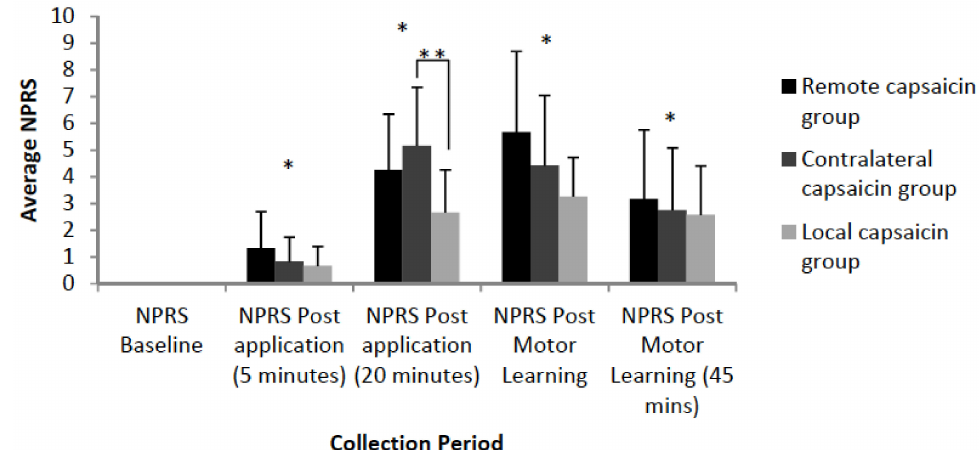
Figure 6. Bar-graph depicting averaged NPRS ratings of participants by group. Significant differences in subjective pain levels relative to baseline were observed for all three groups 5 min post-application ( p < 0.001), 20 min post-application ( p < 0.001), post-motor learning acquisition (35 min mark) ( p < 0.001) and post-motor learning acquisition (45 min mark) ( p < 0.001) as indicated by an asterisk. At 20 min post application there was a significant difference between the local and contralateral groups ( p = 0.02) as indicated by a double asterisk. Error bars represent the standard